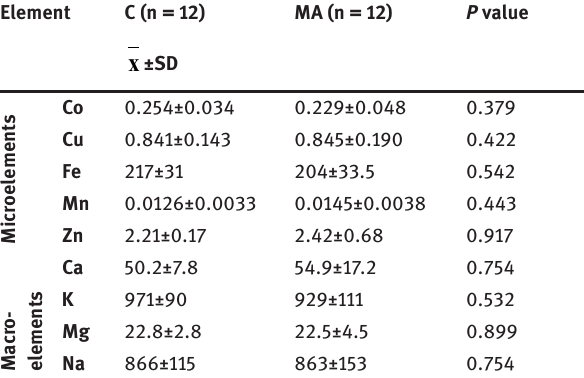
Table 6: The effect of enriched macroalgae on the average content of elements in blood of examined pigs (mg L -1 ).